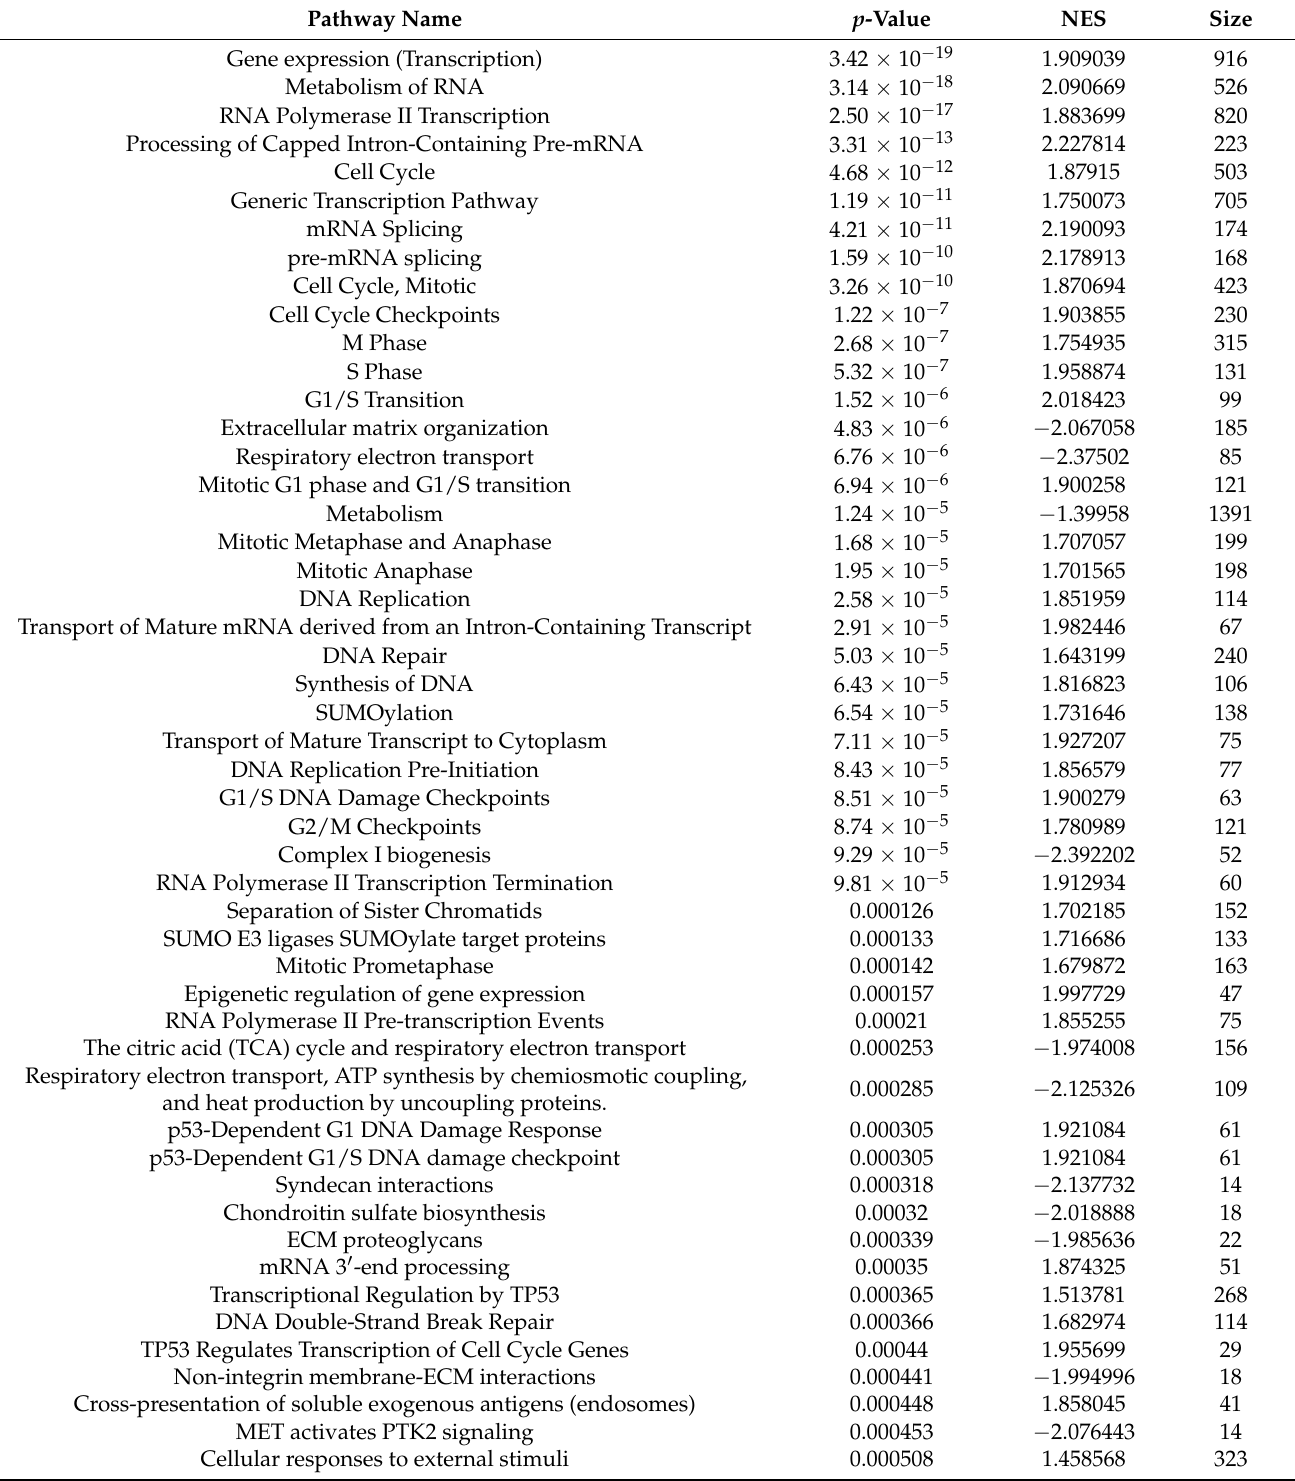
Table 1. Gene set enrichment analysis based on the Reactome database (top 50 based on p